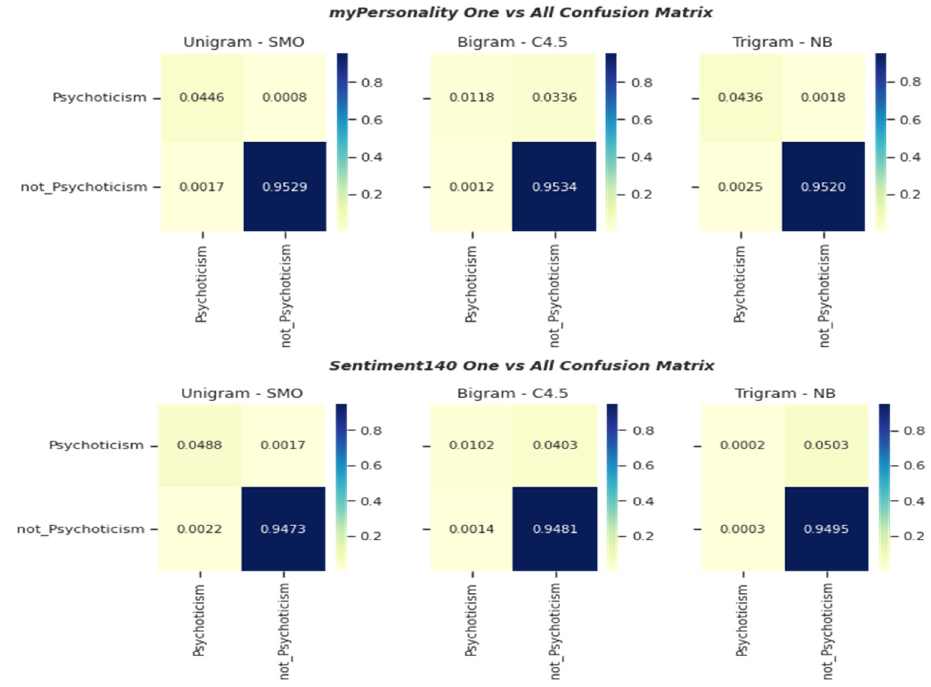
Figure 7. Confusion Matrix of one vs. all Classification.